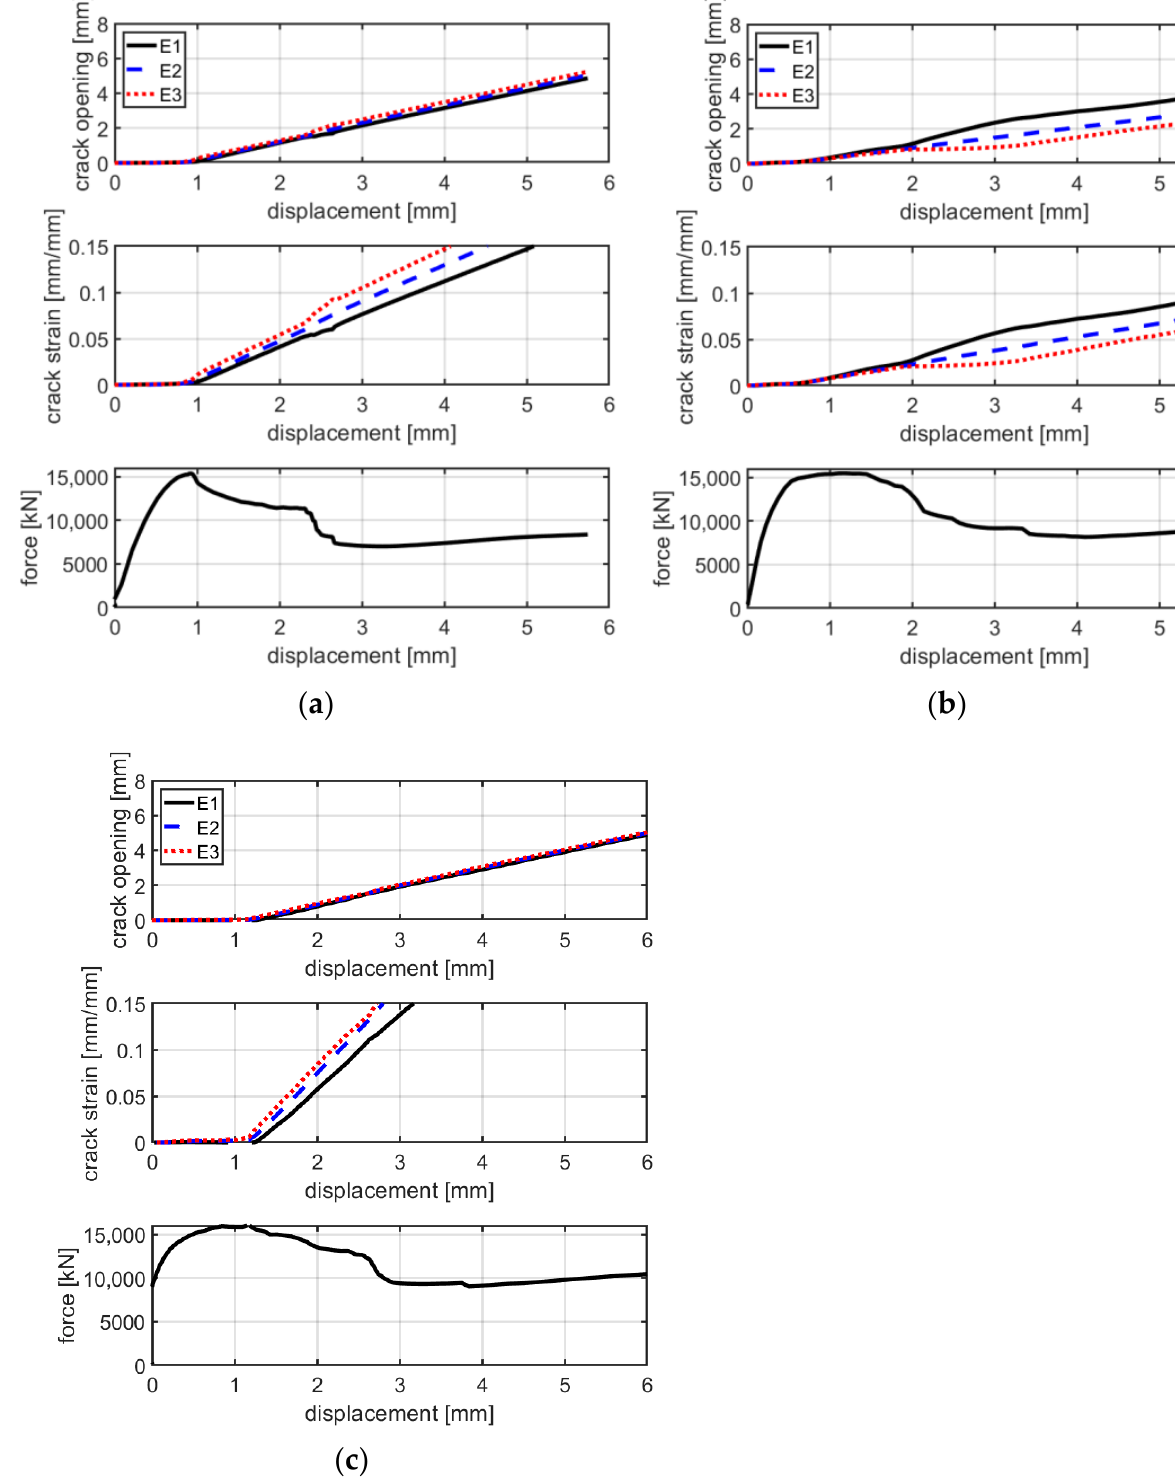
Figure 18. Graphs of crack opening/crack deformation/force-axial displacement of specimens CPf-1 ( a ), CPf-2 ( b ) and CPf-3 ( c ).